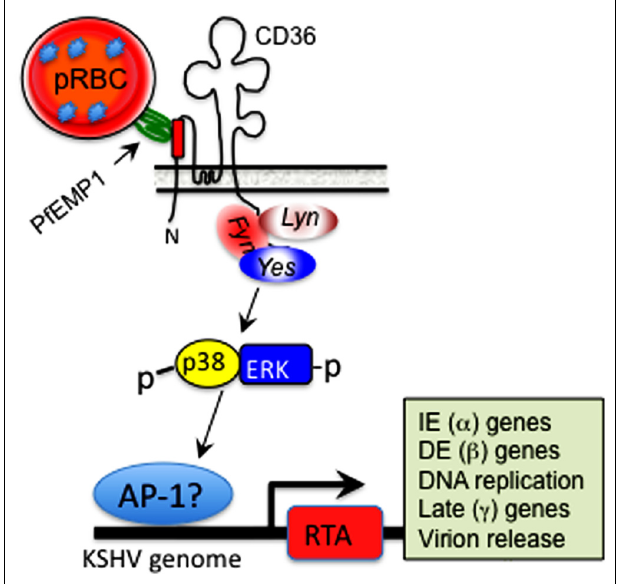
FIGURE 3 | Hypothetical model of CD36-dependent RTA activation. A motif displayed by Pf EMP-1 on the surface of parasitized erythrocytes interacts with its cognate epitope within the ectodomain of CD36 on the surface of microvascular endothelial cells.This interaction activates one or more of the Src -like kinases, which in turn initiate a phosphorylation cascade that results in p38 and ERK/MAPK activation.This process culminates in activation of a cellular transcription factor, likely AP-1 (dimer of c-jun and c-fos ), which translocates into the nucleus and stimulates KSHV RTA-dependent transcription of viral lytic cycle genes, starting with immediate early (IE), which then activate delayed early (DE), followed by late structural genes involved in assembly of an infectious virus